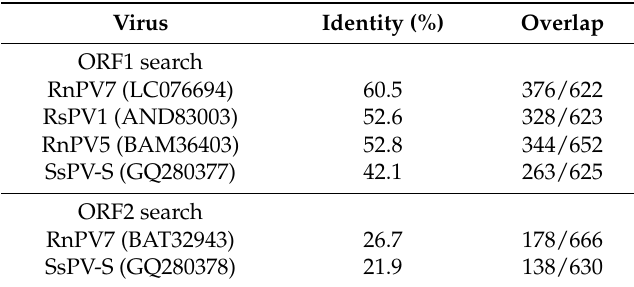
Table 1. Amino acid sequence identity (%) between T. atroviride alphapartitivirus 1 (TaPV1) ORF1, ORF2 and other viruses from the genus Alphapartitivirus